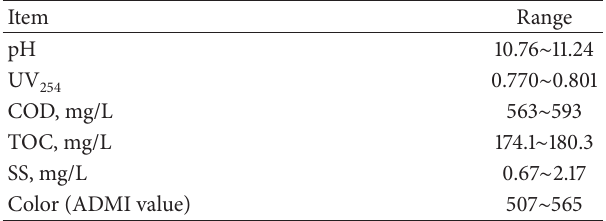
Table 1: Characteristics of electro-optical industry wastewater.